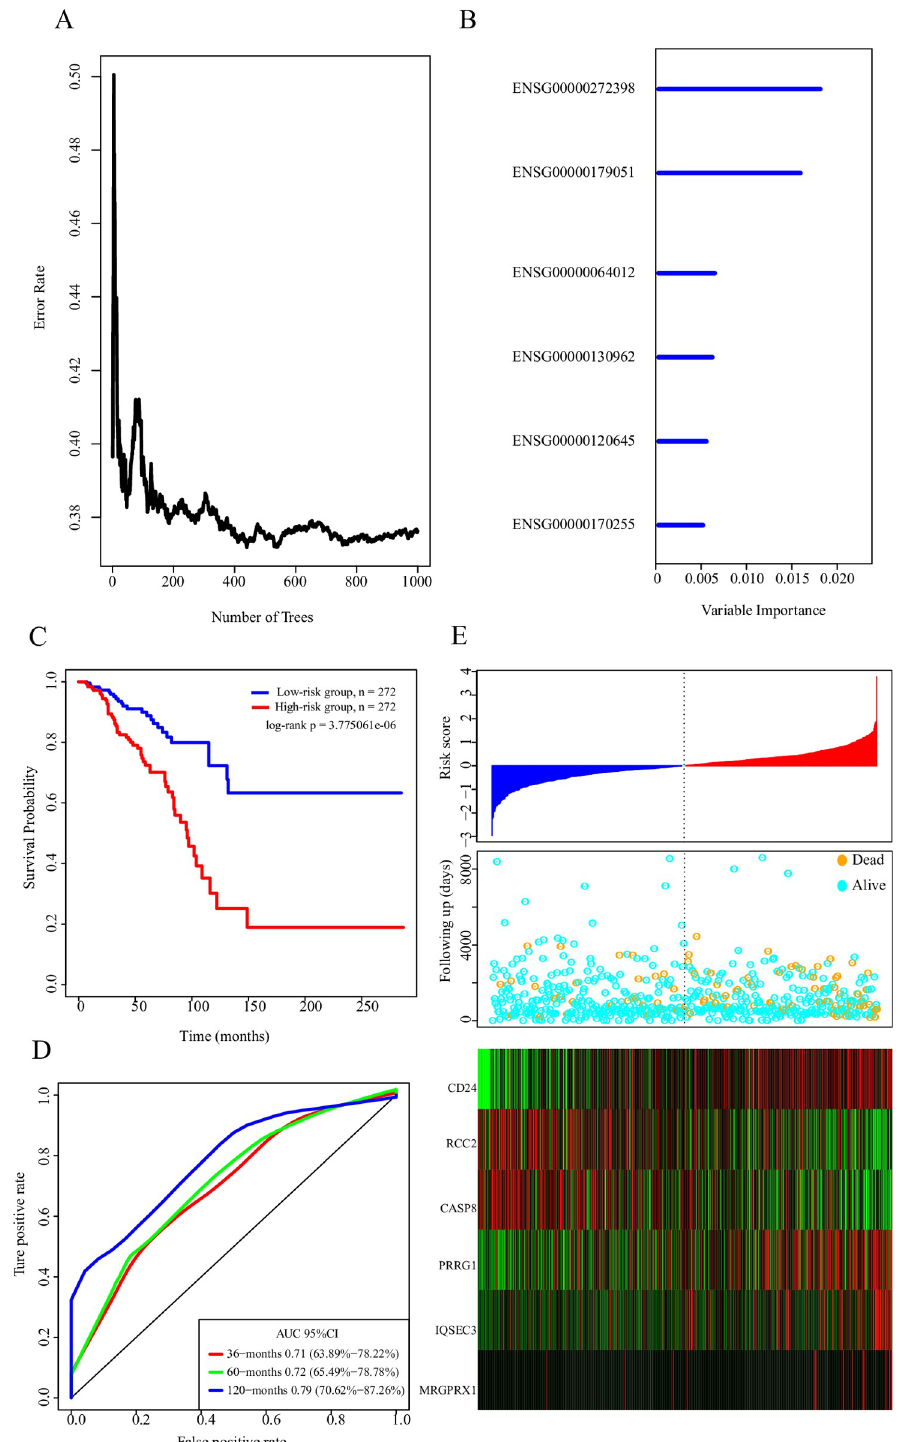
Fig 3. A: The relationship between the error rate and the number of classification trees. B: The importance of out-of- bag of the first 6 genes. C: KM survival curve distribution of the 6-gene signature in the TCGA training set. D: The ROC curve and AUC of the 6-gene signature classification. E: Risk score, survival time, survival status and expression of the 6 genes in TCGA training.